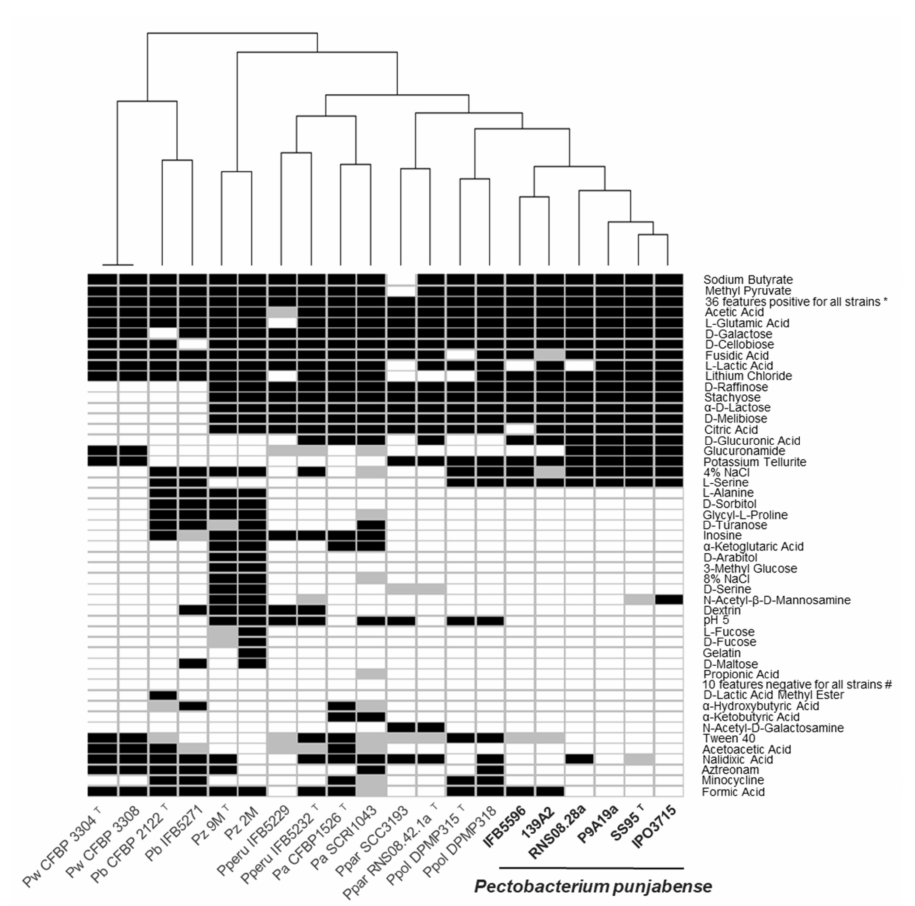
Figure 3. Results of the BIOLOG assay with the strains panel of P. punjabense and other closely related species.